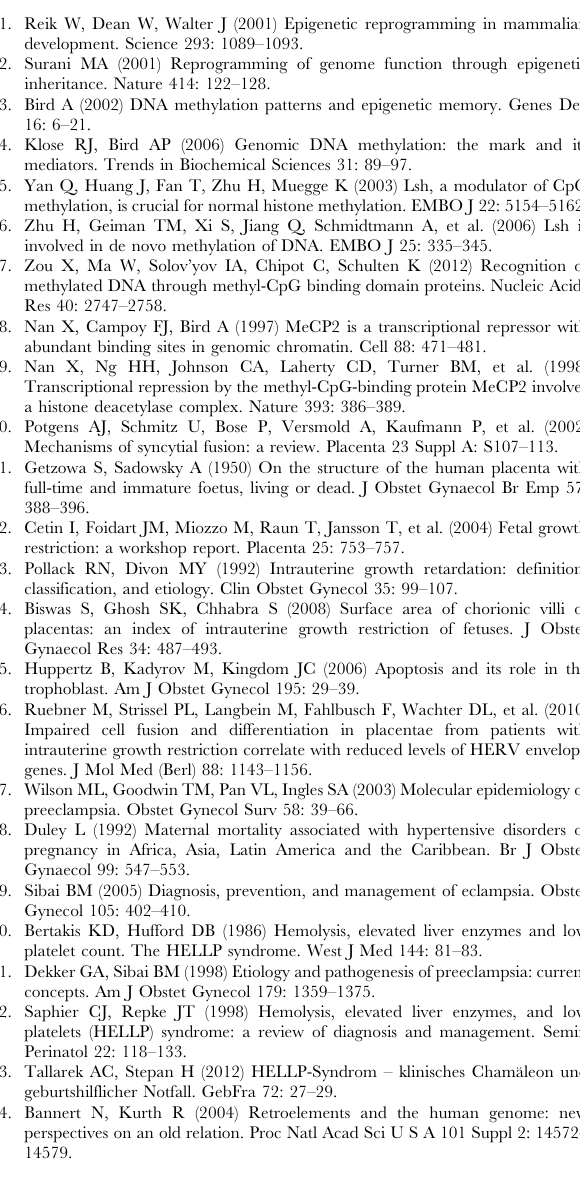
Table S1 Methylation pattern of isolated tropho- blasts. Methylation pattern of all 22 CpGs of isolated trophoblasts from control (n= 3), IUGR (n= 3), PE (n =3), PE/ IUGR (n= 3) and HELLP/IUGR (n= 2) placentae. CpG ( 2 1) and CpG ( 2 2) are located within the TSE and CpG 1 to 20 within the 5 9 LTR (Fig. 1A). Syncytin-1 gene expression is shown in molecules/ng cDNA . p , 0.05 R statistically significant.